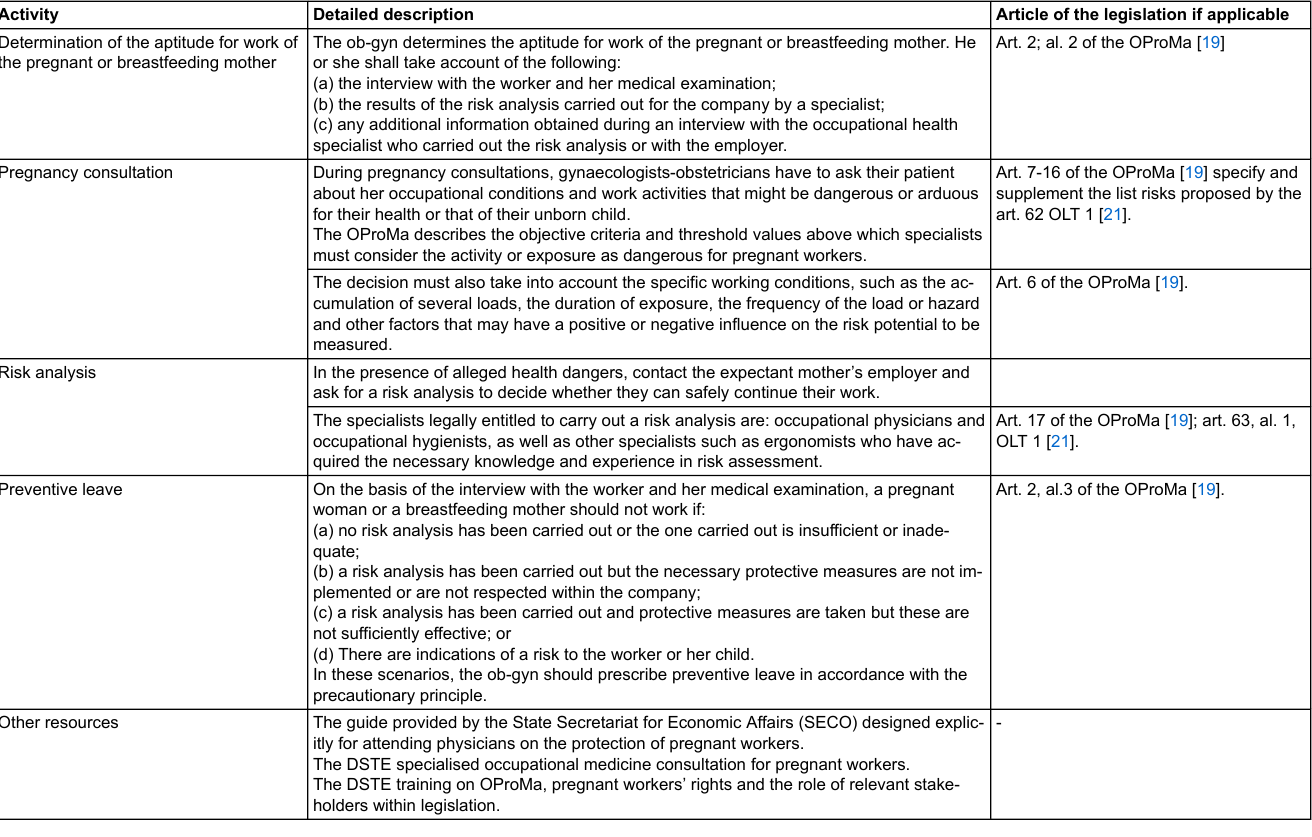
Table 2: Overview of gynaecologists-obstetricians’ best practices as detailed in Swiss legislation Activity Detailed description Determination of the aptitude for work of the pregnant or breastfeeding mother